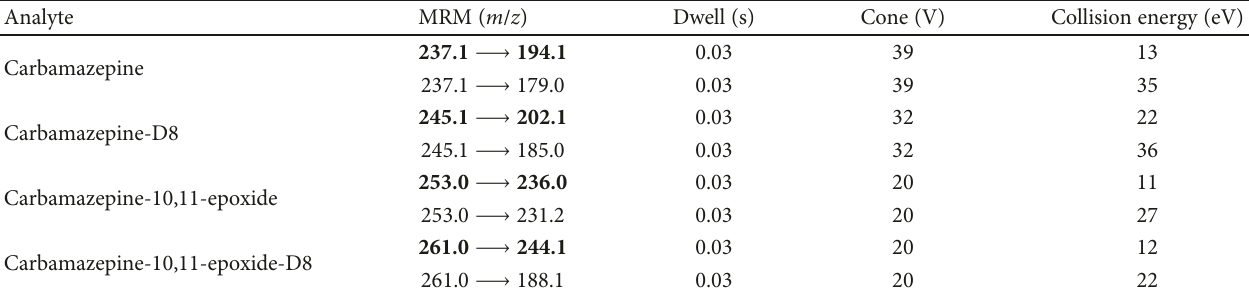
Table 1: Multiple reaction monitoring (MRM) transitions monitored ( m / z ) with cone and collision energy.